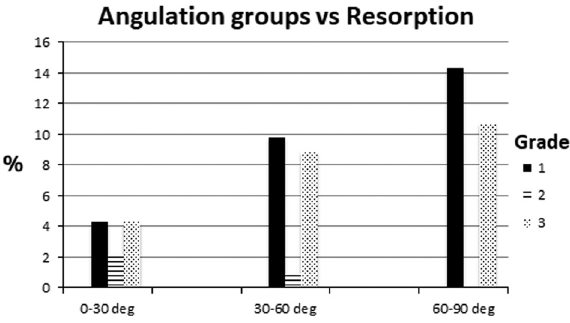
Figure 7. Relationship of gender to the severity of resorption.